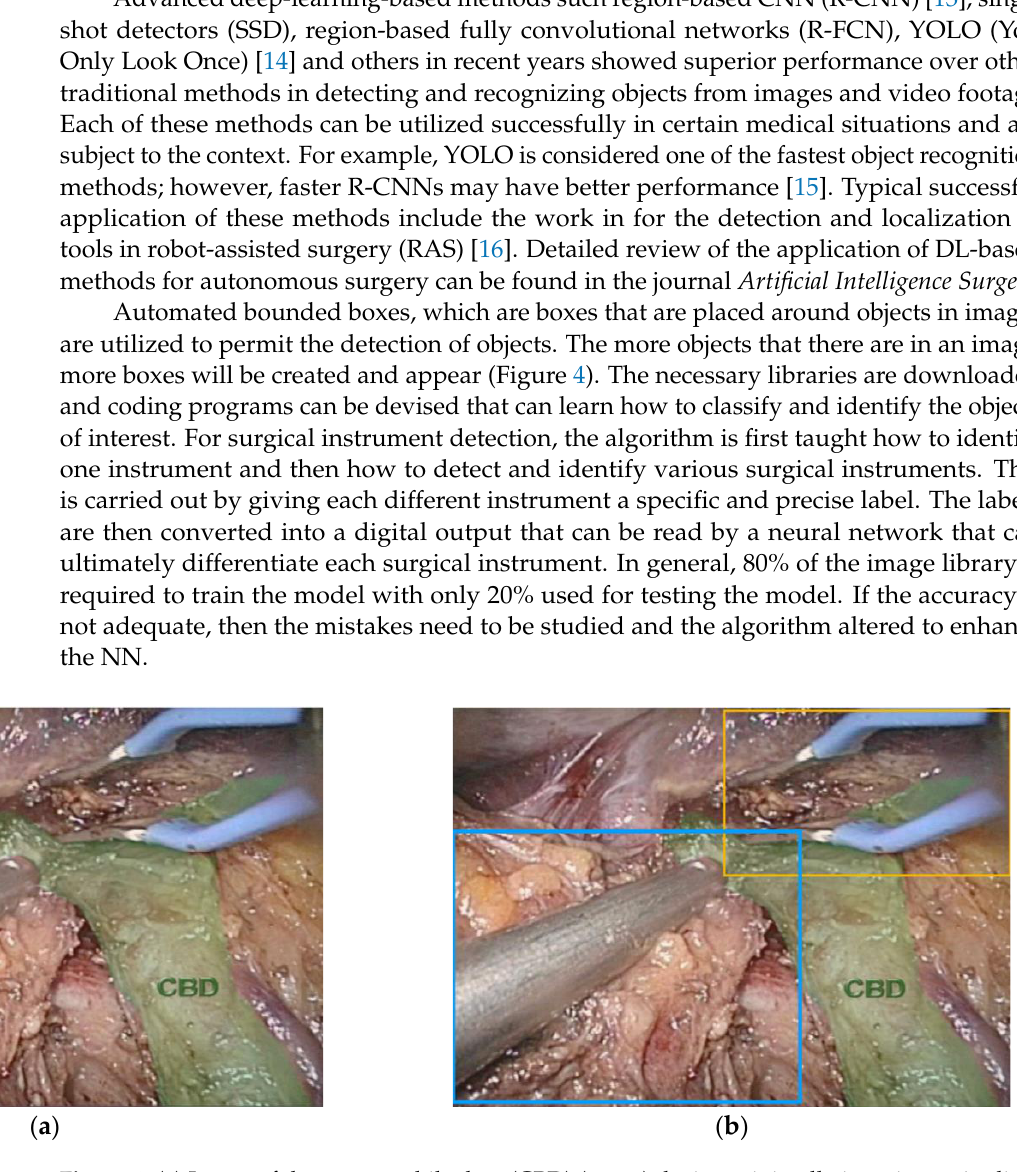
Figure 4. ( a ) Image of the common bile duct (CBD) (green) during minimally invasive major liver resection and ( b ) bounded boxes around surgical instruments. Notice that the left and right hepatic ducts are not labeled.